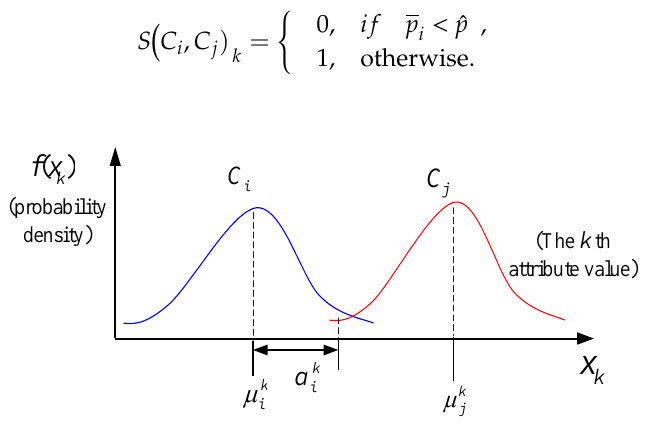
p . Figure 5. Separation of two classes based on p i i